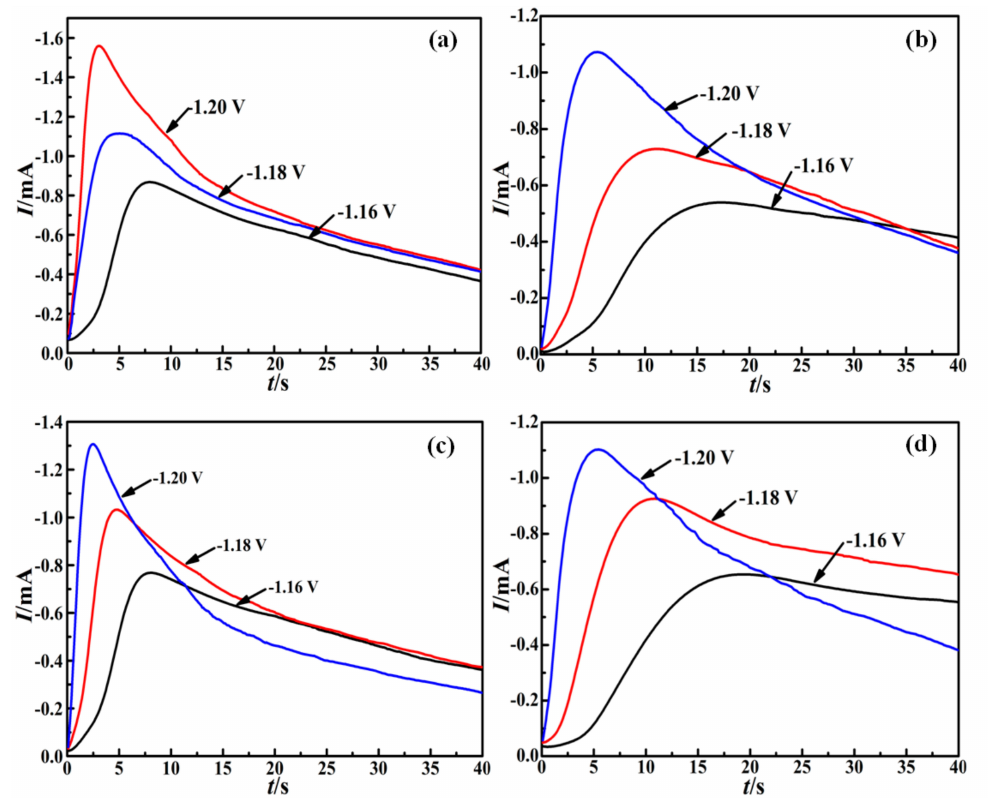
Figure 3. Typical current-time transient for nickel electrodeposition in the presence of additives at different potentials. ( a ) TU, ( b ) TU+ CTAC, ( c ) TU+ SDS, ( d ) TU +